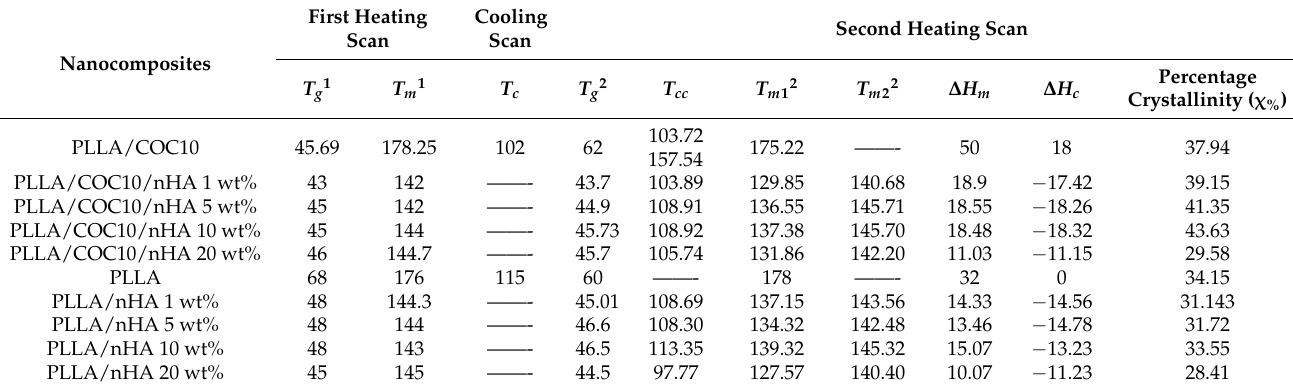
Here T g 1 is the T g found in first heating while T g 2 is the T g in second heat. T m 1 is the melting temperature in first heat whereas T m 12 and T m 22 are first and second melting point peaks in second